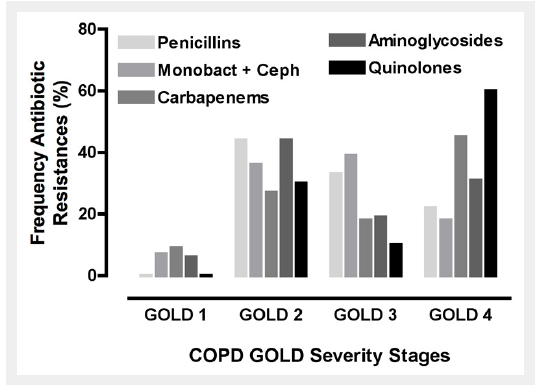
Frequency of resistances against anti-pseudomonas antibiotic classes in different COPD stages (GOLD 1-4) for patients colonised with P. aeruginosa (n = 112). Anti-pseudomonas antibiotic groups: Penicillins, extended spectrum penicillins (Ticarcillin, Ticarcillin/ Clavulanic acid, Piperacillin, Piperacillin /Tazobactam), Monobact + Ceph, monobactams and cephalosporins, (Ceftazidim, Cefepime, Aztreonam), carbapenems (Imipenem, Meropenem), aminoglycosides (Gentamicin, Amikacin, Netilmicin, Tobramycin), and quinolones, fluoroquinolones